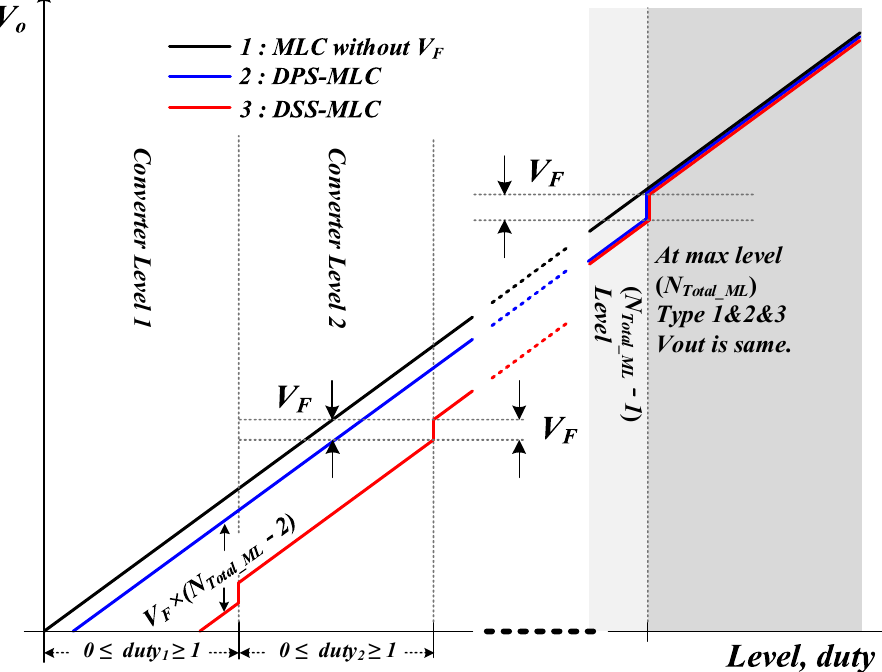
Figure 10. Output characteristics considering the diode voltage drop.